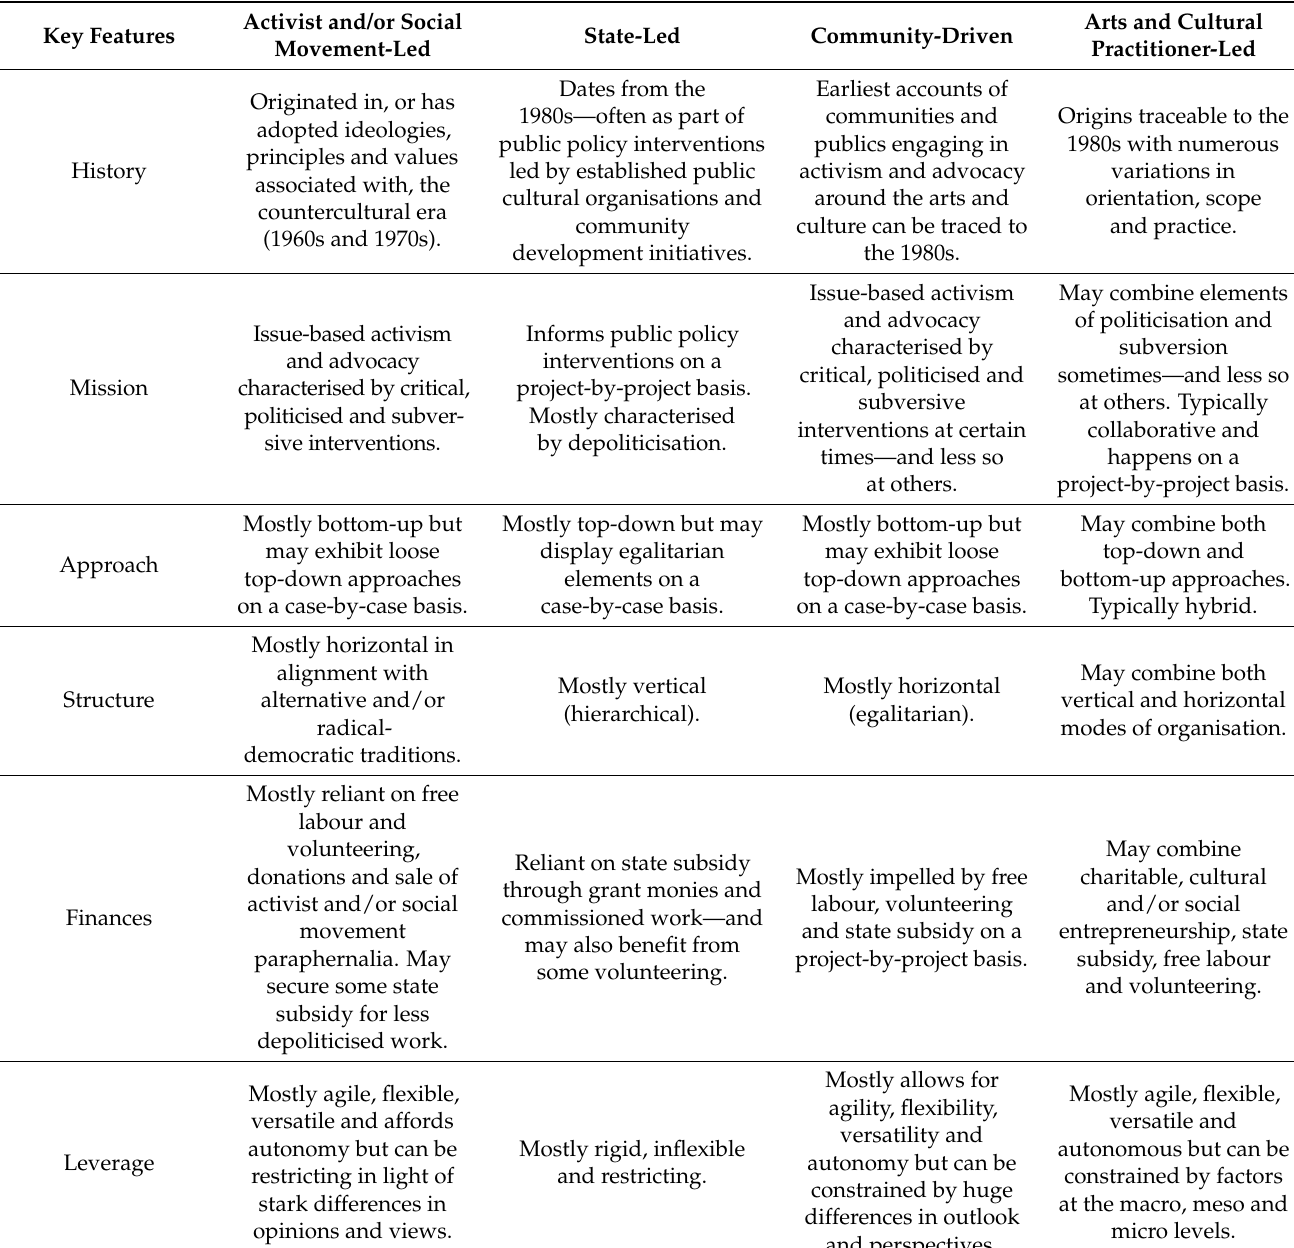
Table 1. Main versions of community engagement in cultural and creative